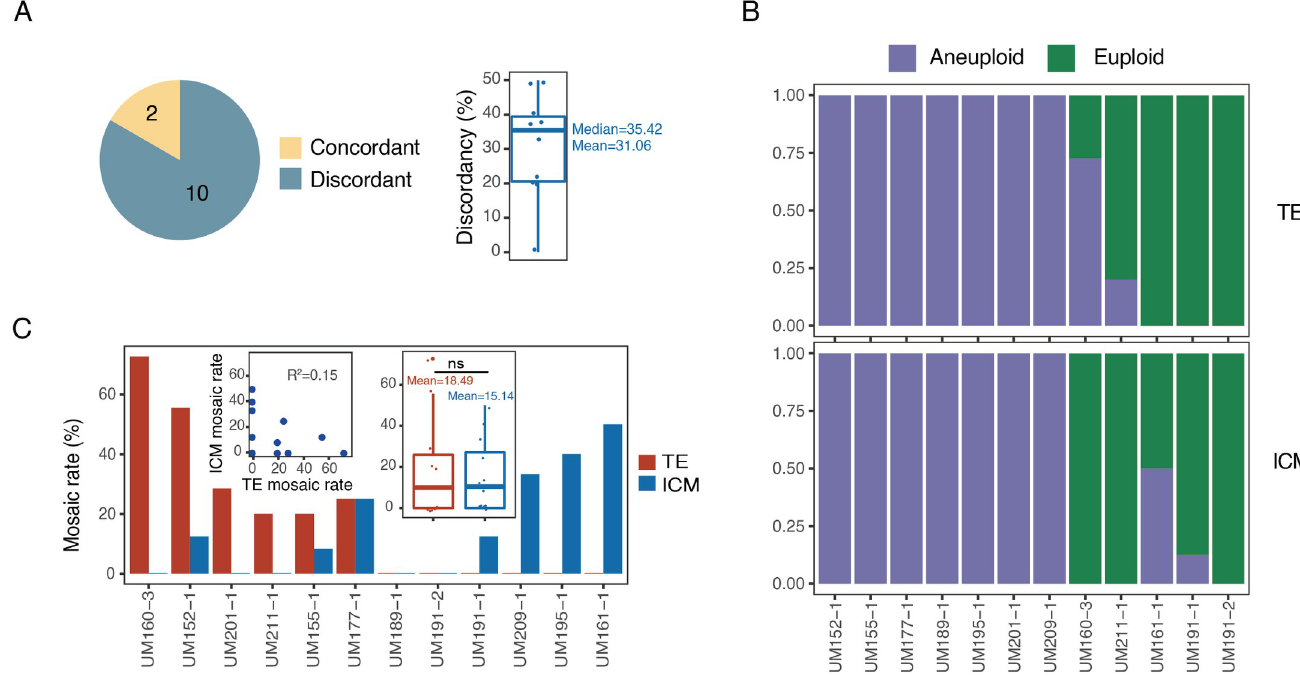
Fig 2. Analysis of chromosome copy number of TE and corresponding ICM from the same embryo. A) Number of TE-ICM concordant (n = 2) and TE-ICM discordant (n = 10) embryos (left) and the discordancy of the 10 TE-ICM discordant embryos (right). Among the 12 embryos having both TE and ICM cells analyzed, 2 embryos showed the concordant chromosome status and 10 embryos showed discordant chromosome status. Of the 10 TE-ICM discordant embryos, they showed a mean of 31.06% discordancy. n, number of embryos. B) Chromosome status of the matched TE-ICM in each embryo (n = 12). Two (UM160-3, UM211-1) of the 12 embryos had aneuploid TE cells but showed euploid ICM cells. Another two (UM161-1, UM191-1) embryos showed euploid TE cells but had aneuploidy ICM cells. n, number of embryos. C) Mosaic rates of the matched TE-ICM in each embryo (n = 12). The barplot showed the mosaic rates of TE and ICM from 12 embryos with both TE and ICM cells. The left insert dotplot showed the relation between the mosaic rate of TE and matched ICM. The right insert boxplot showed the mosaic rates of TE and matched ICM. n, number of embryos.